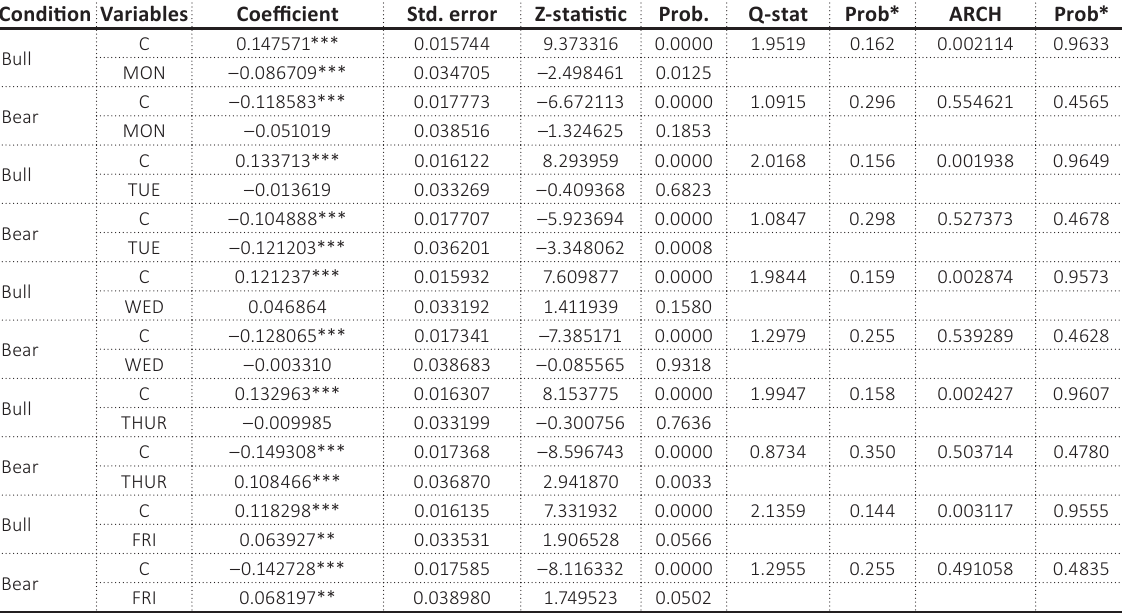
Table 3. Results of day-of-the-week in Up and Down condition Condition Variables